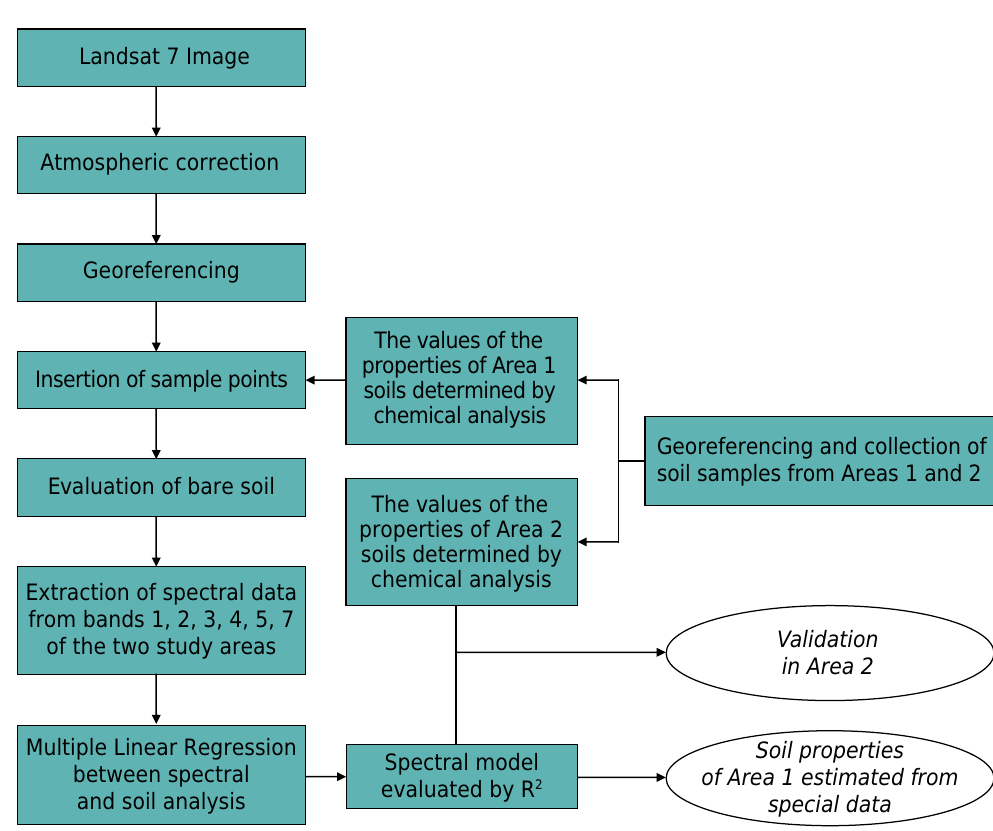
Figure 1. Flow chart with main steps adopted in the present study to quantify the soil particle